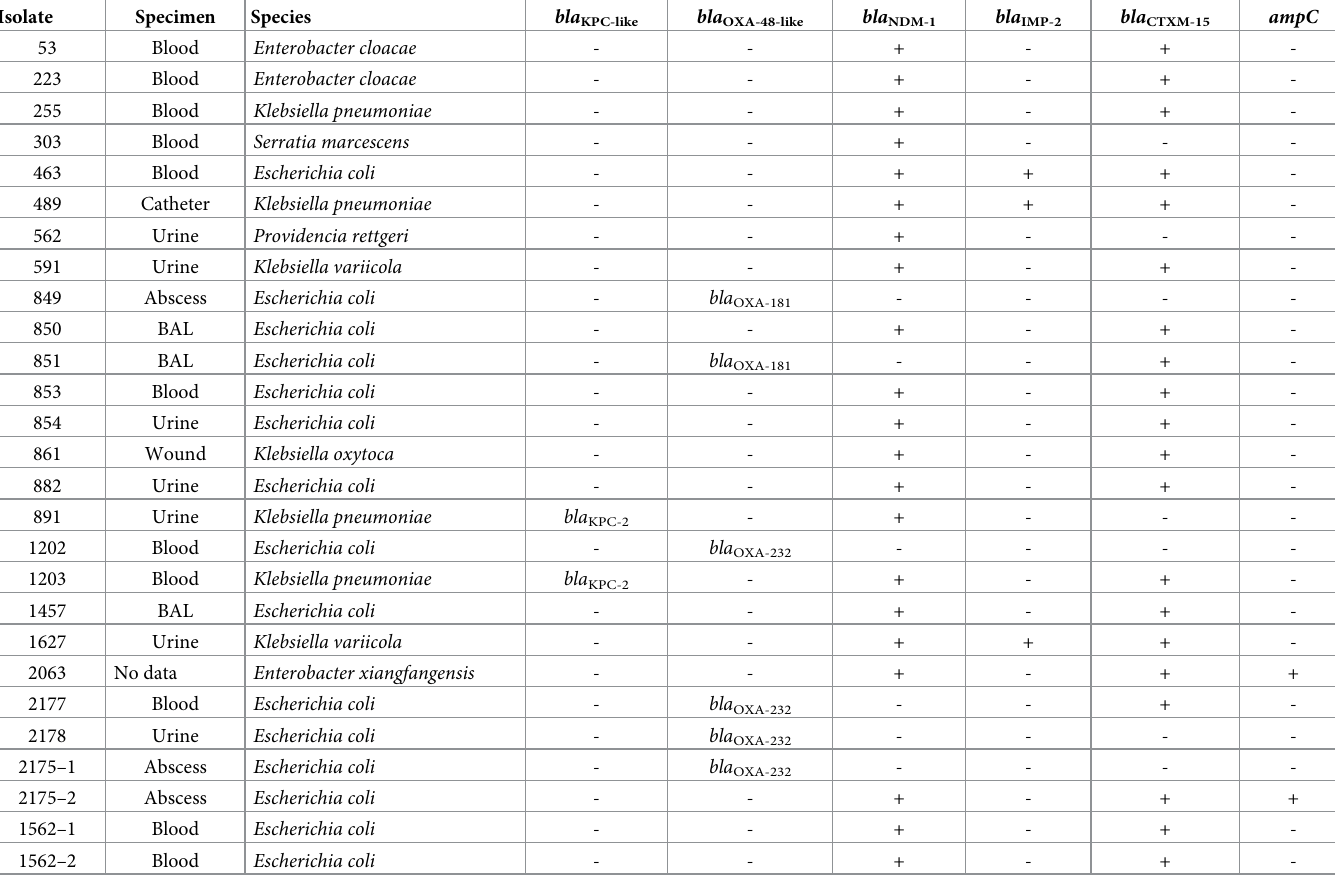
Table 6. Distribution of carbapenemase-encoding genes among selected carbapenem-resistant Enterobacteriaceae a .